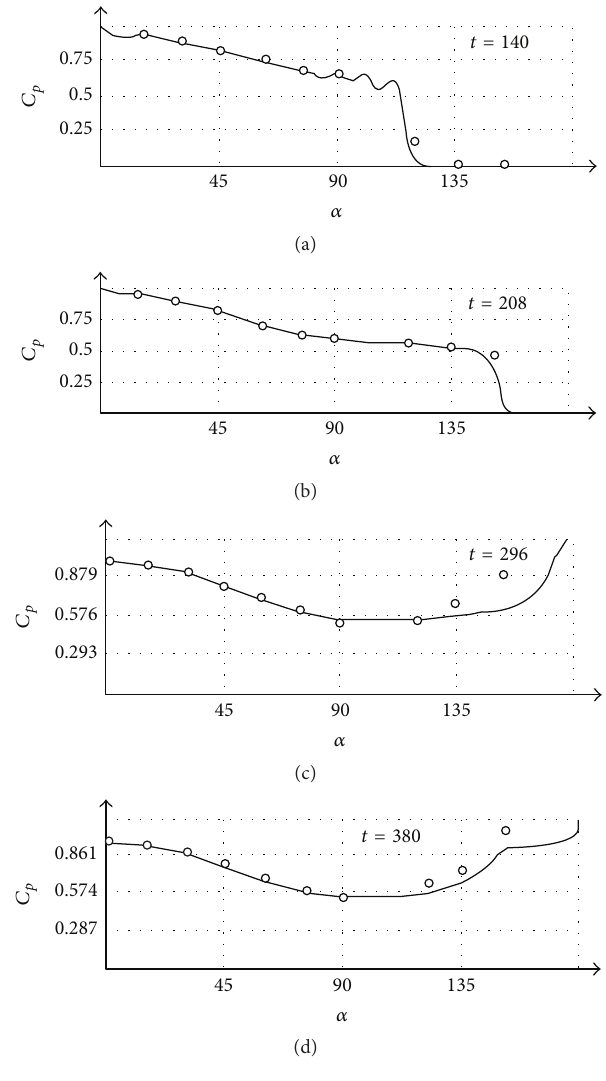
Figure 3: Dimensionless pressure distribution around the sphere versusangle.Solidline:numericalresults;opencircles:experimental findings by Tanno et al.